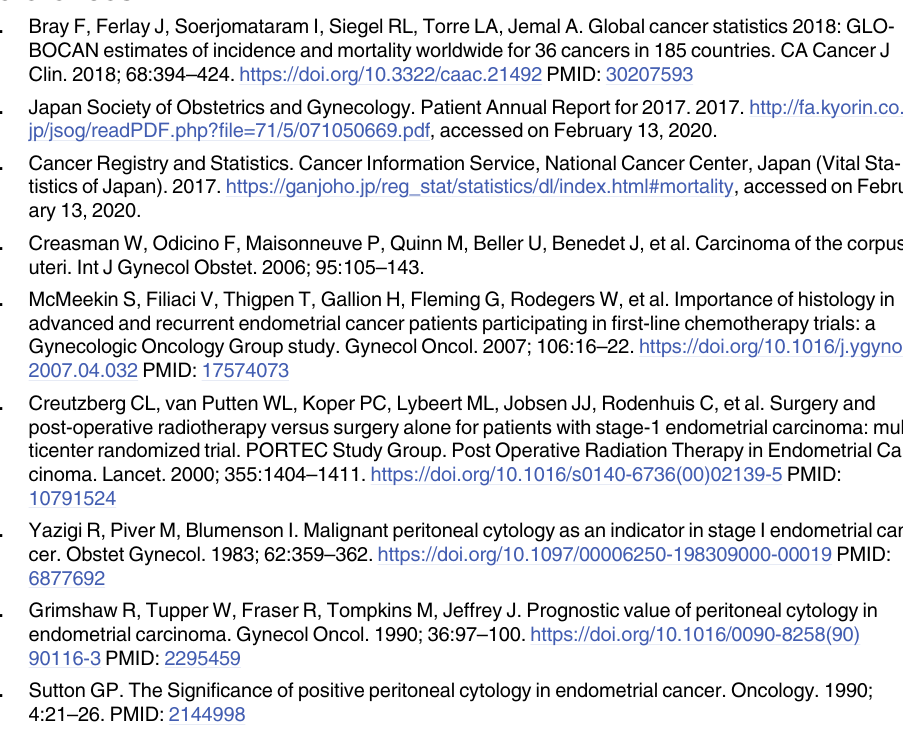
S1 Table. Correlations between SII for OS and clinicopathological characteristics. S2 Table. Summary of investigations of the role of SII in endometrial cancer